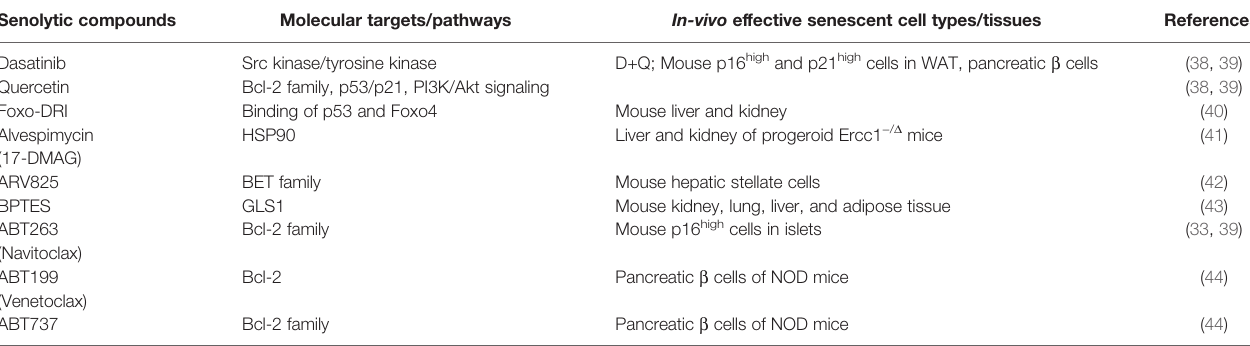
TABLE 1 | Senolytic compounds and their molecular